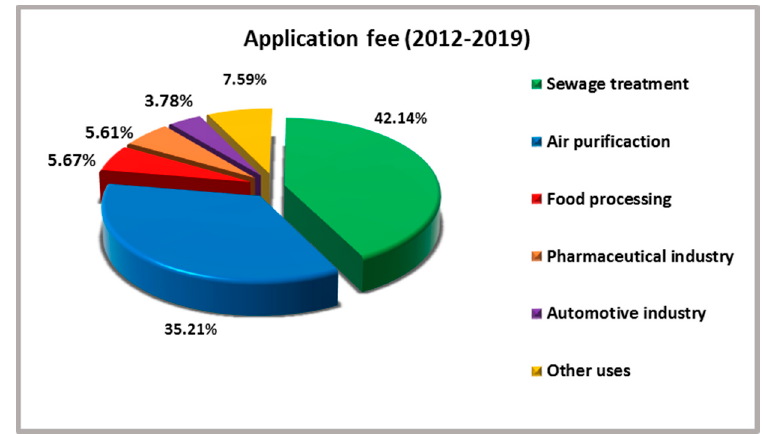
Figure 3. Application fee (2012–2019).